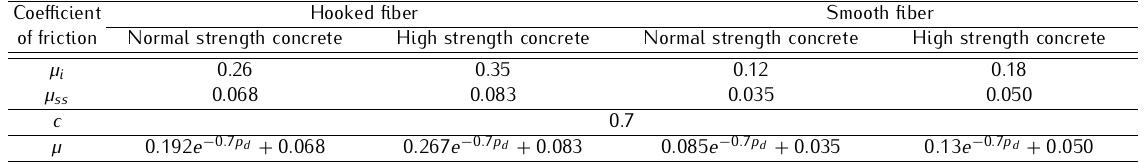
Table 6. Proposed models for the coefficient of friction µ